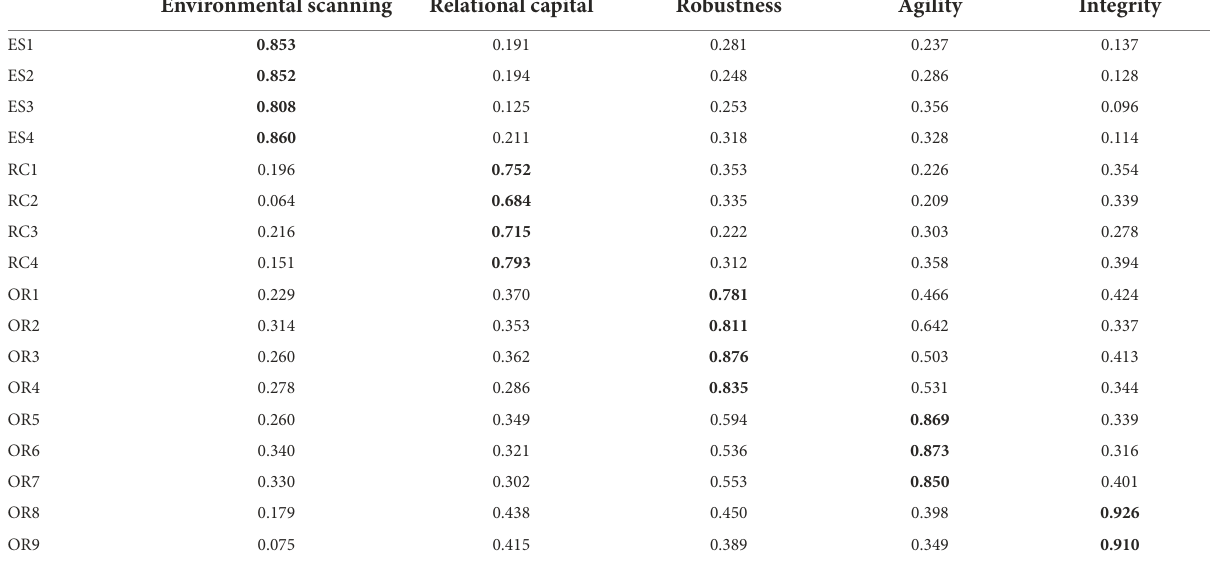
TABLE 3 Cross loadings of individual items.